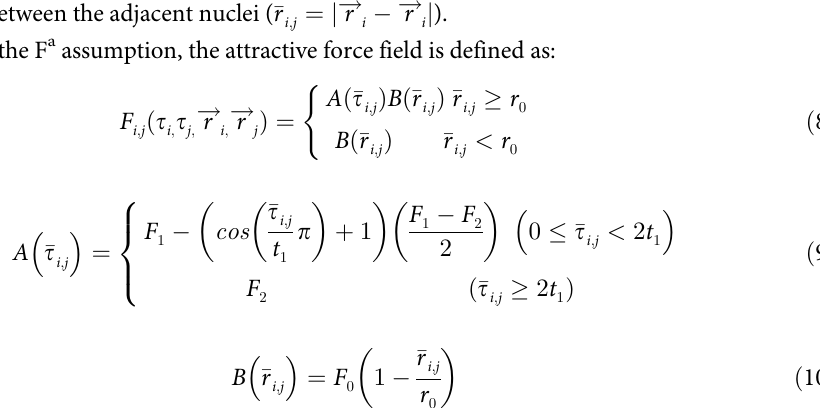
Table: t = 0.23; F = 1; F = 0.2; r = 8.5; F = 15. The nuclear cycle time is set as 1. For other 1 1 2 0 0 force fields, see S8